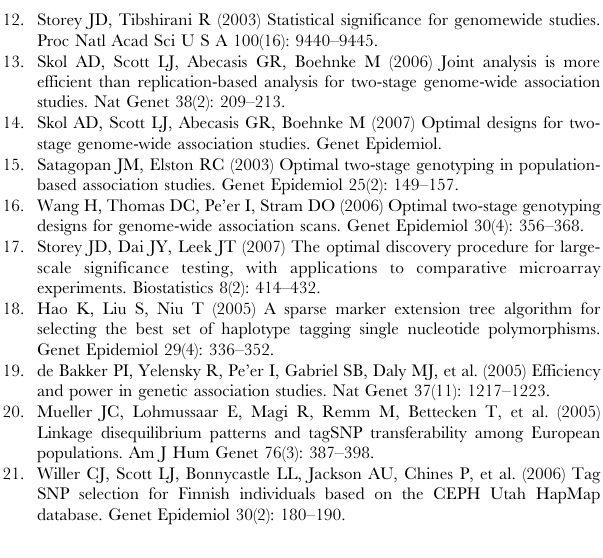
Table S1 Genetic Coverage of tagSNP Arrays. Table S2 Power and Number of Discoveries (ND) of Whole Table S3 Number of False Discoveries in Mapping Quantitative